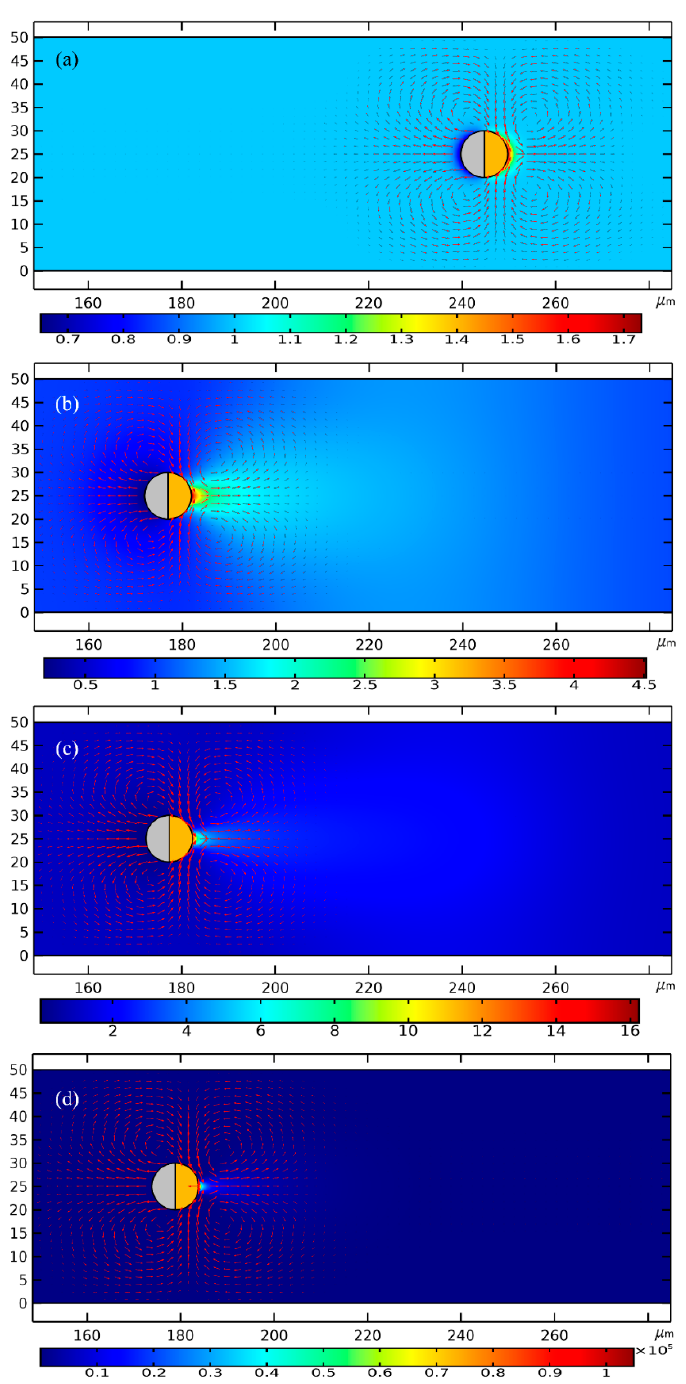
Figure 8. A simulation study of the application of the ICEP-enabled unidirectional delivery of the Janus ME (PP) in simultaneous electroconvective loading and collection of the nanoscale biomolecules (SP) from the surrounding liquid suspension in the low-frequency limit. ( a – d ) An arrow plot of the EHD vortex flow field around the ME, and a surface plot of the concentration field of the biomolecules (unit: nM) inside the fluidic chamber at f = 100 Hz, ( a ) at t = 0 s, ( b ) at t = 0.5 s for V AC = 1 V, ( c ) at t = 0.22 s for V AC = 1.5 V, and ( d ) at t = 0.17 s for V AC = 2 V (See Supporting Video S3). In ( b – d ), the Janus PP has moved a same horizontal distance of 70 µ m as compared to ( a ). Besides, with increasing voltage from ( b ) to ( d ), the concentrating factor of the SP enhances sharply, while the collection area shrinks gradually.